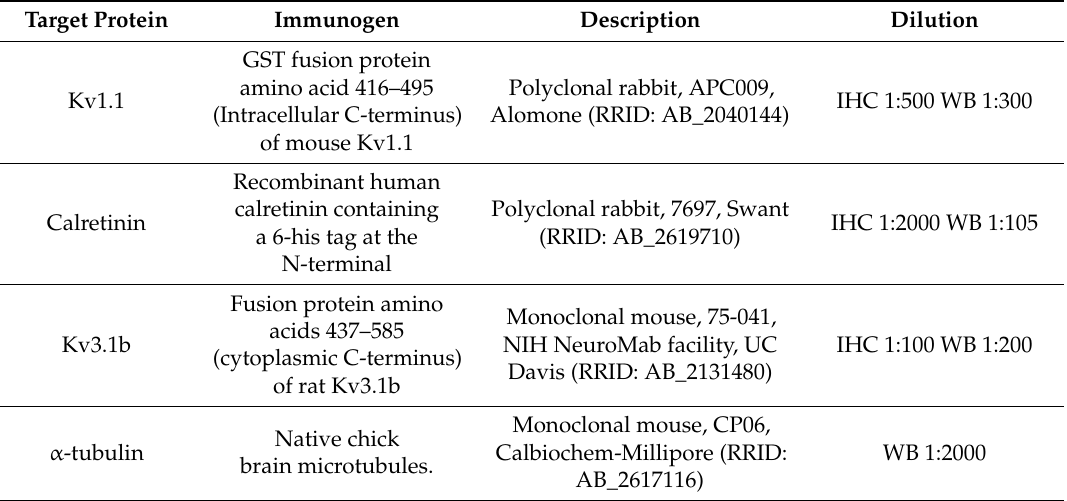
Table 1. Primary antibodies